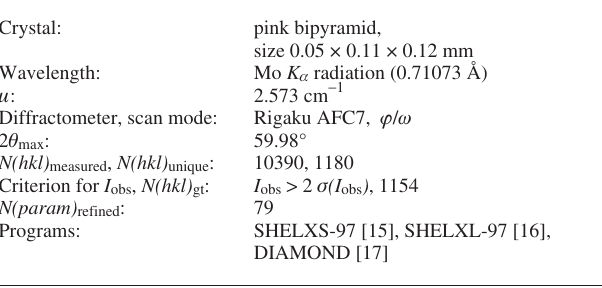
Table 1. Data collection and handling.